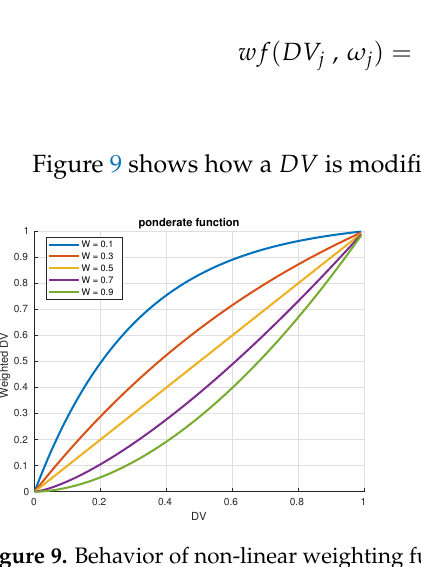
Figure 9. Behavior of non-linear weighting function wf ( DV , ω ) for different values of ω .